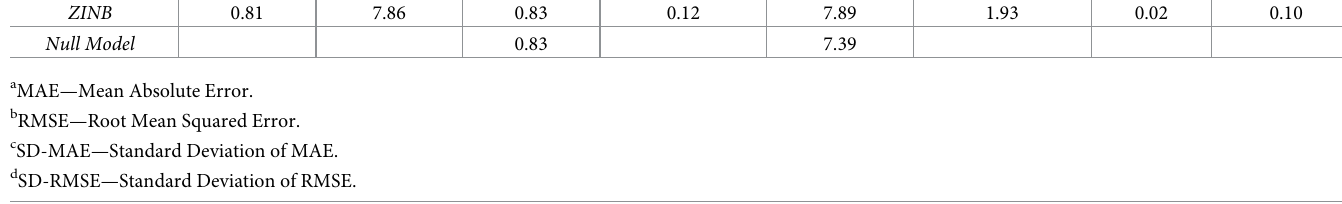
Table 3. Summary of model performance for GFF model.